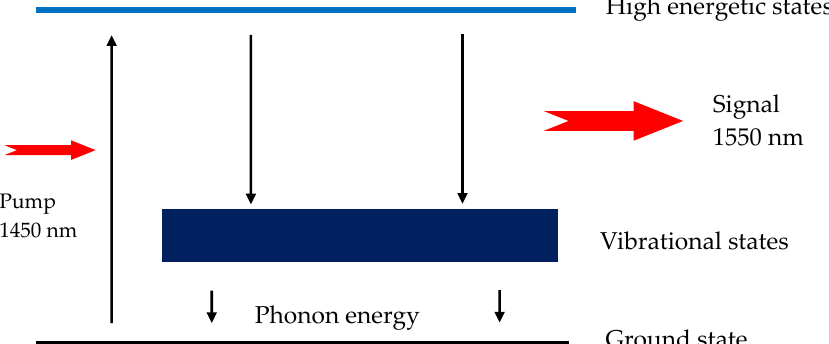
Figure 11. Schematic diagram of energy levels for the stimulated Raman inelastic scattering (SRS) process (silica fiber with very short high-energy-level